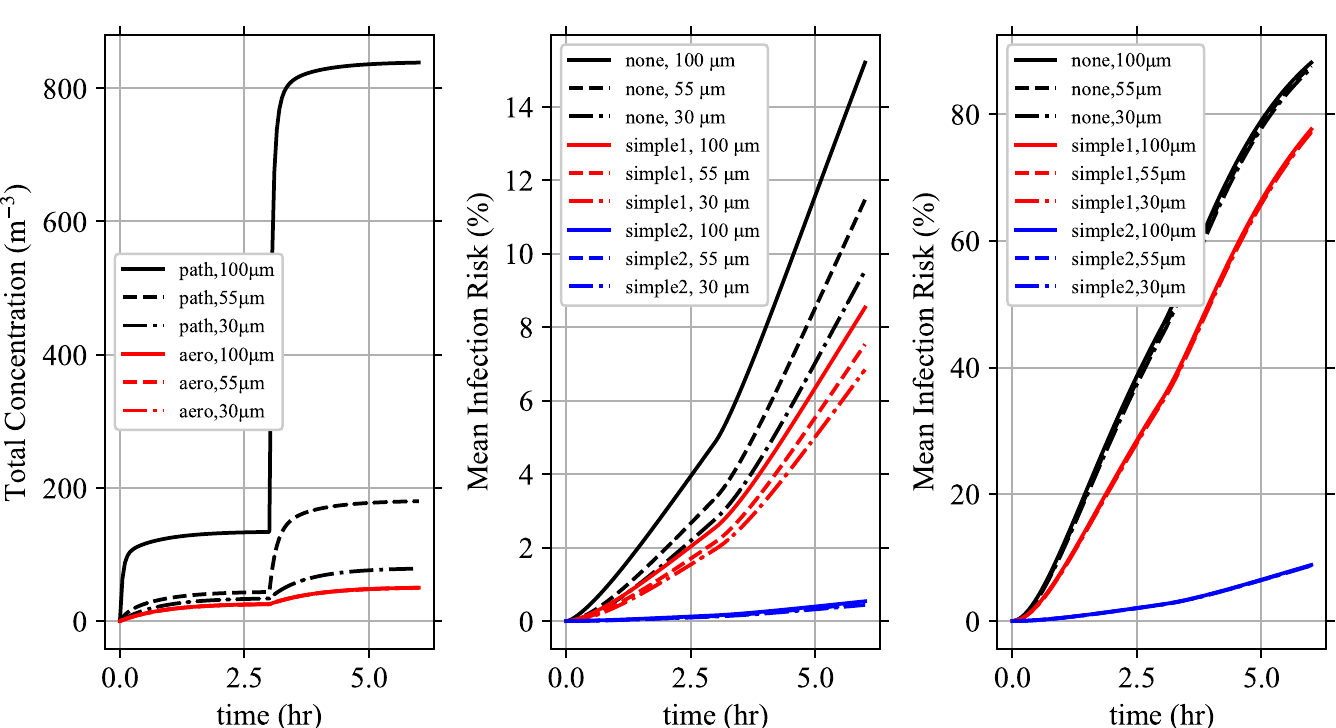
Fig 7. Effect of upper diameter limit d M . The example situation was calculated for different values of the upper diameter limit d M (technically, calculated at the largest and then truncated down as needed). (Left) The total pathogen and infectious aerosol concentration densities over time for each d infectious aerosol concentration density are so small that the lines are right on top of each other. The mean infection risk for each combination of masks on a susceptible individual (none, simple1, simple2) for (Middle) r = 2.45 × 10 − 3 and (Right) r = 5.39 × 10 − 2 .